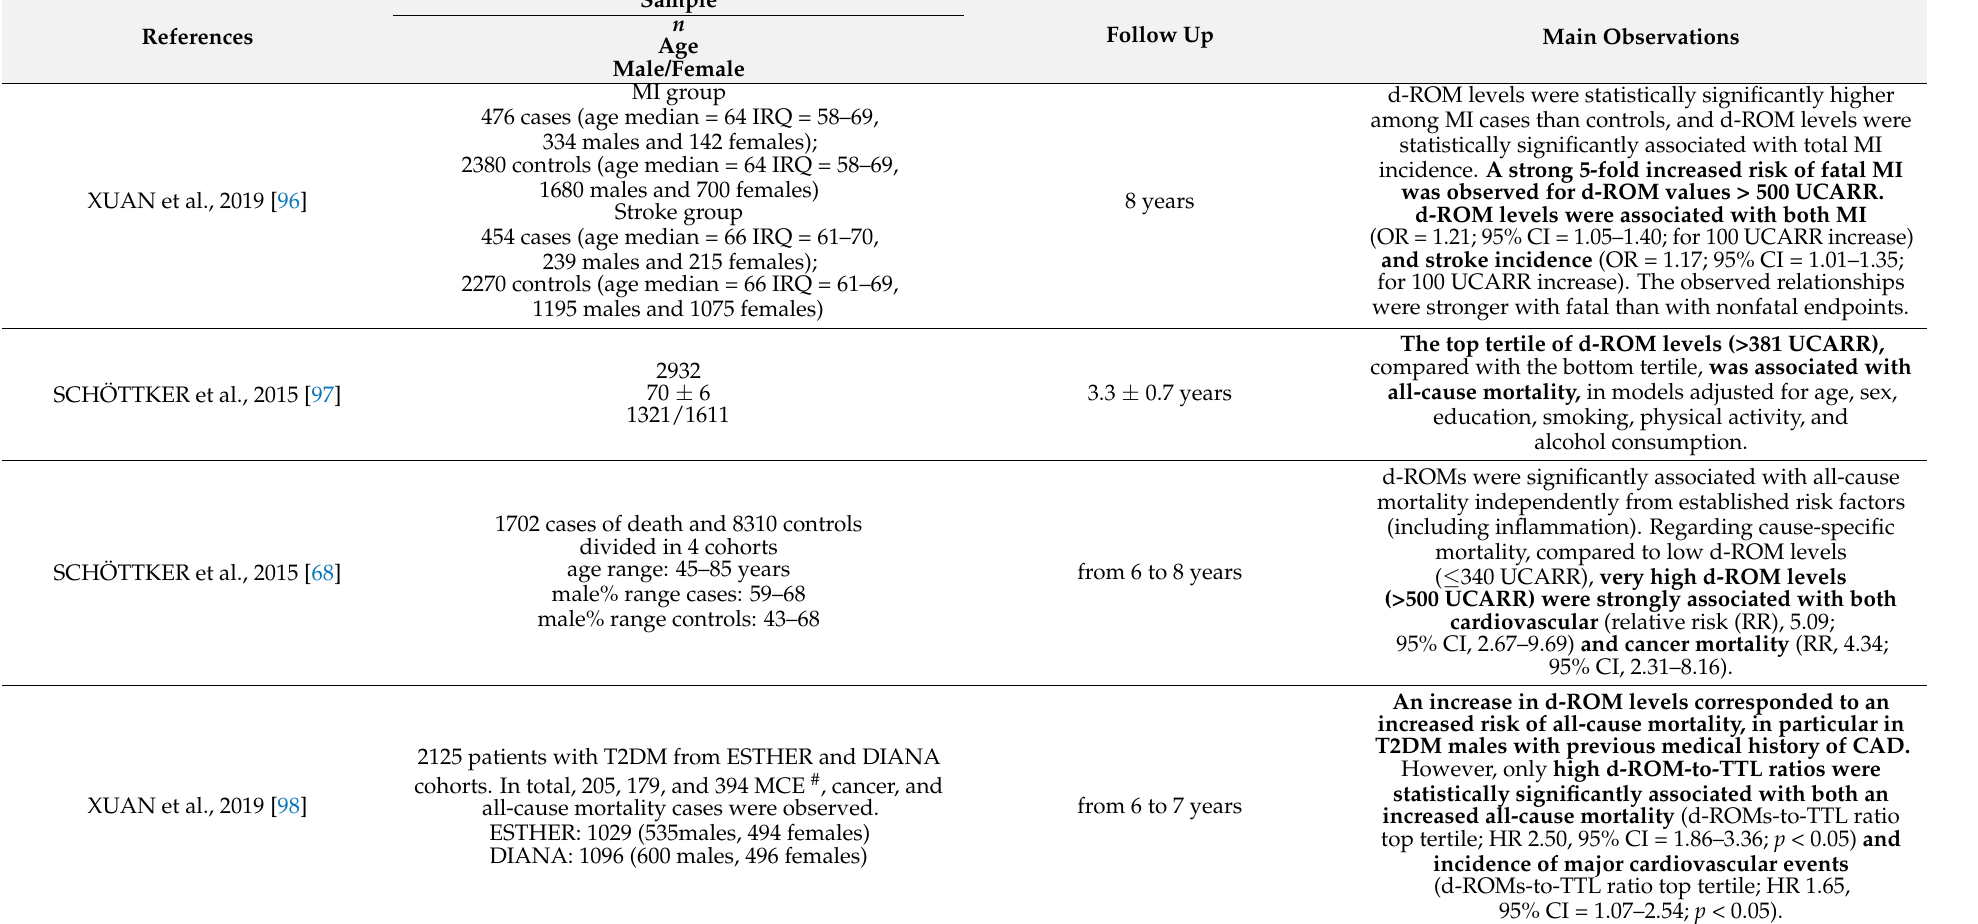
Table 2. List of studies analysing the correlation of d-ROM values with CVD events and mortality in large population-based